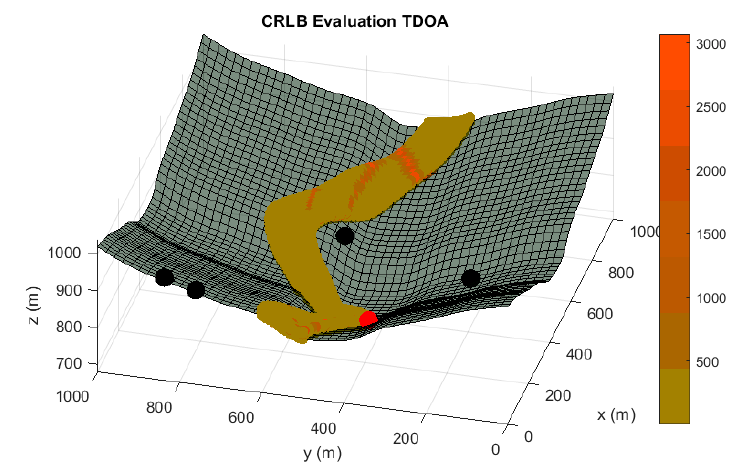
Figure 3. Accuracy analysis in terms of Cramer Rao Lower Bound (CRLB) in meters for a random sensor distribution of five sensors, under the assumption of one randomly malfunction sensor. Black spheres indicate the location of active sensors and red spheres highlights the sensor which is not available. Red tones in the color bar indicate bad accuracy evaluations, while green tones imply acceptable accuracy values.